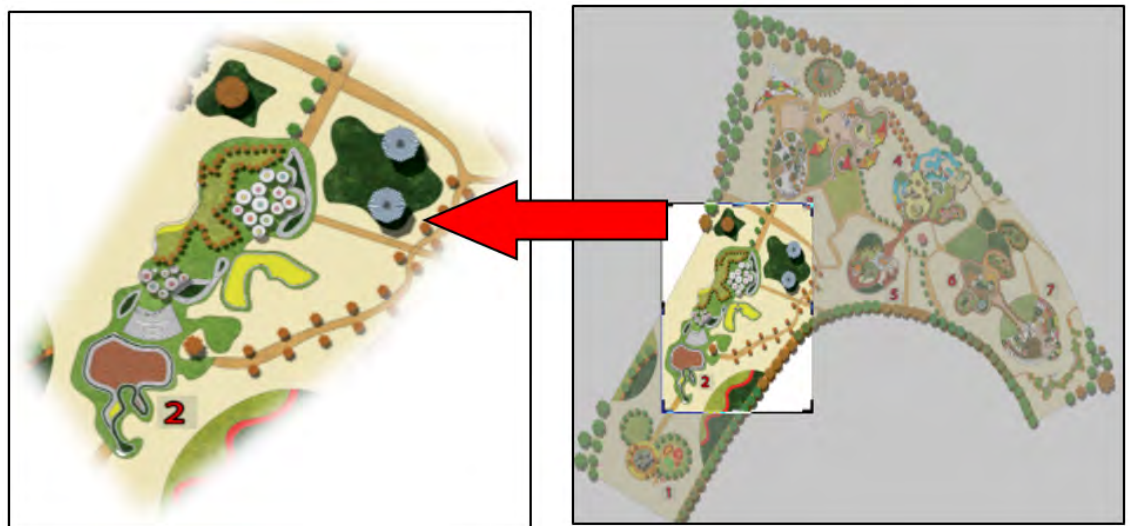
Figure 8. The location of “become the animal” zone